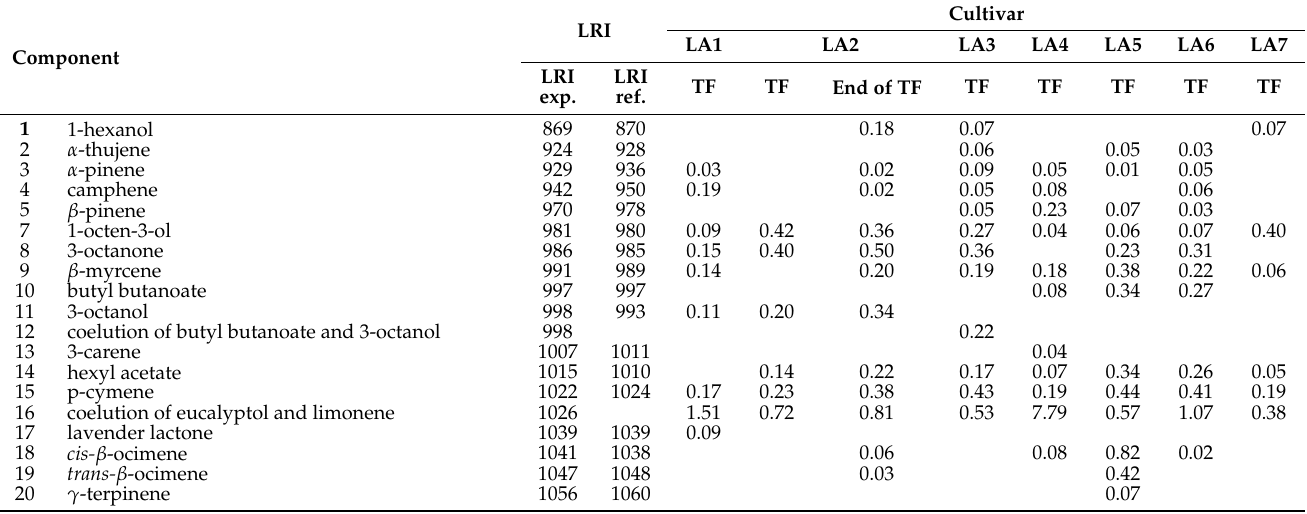
Table 2. Relative abundances (in %) of components in essential oils from seven new